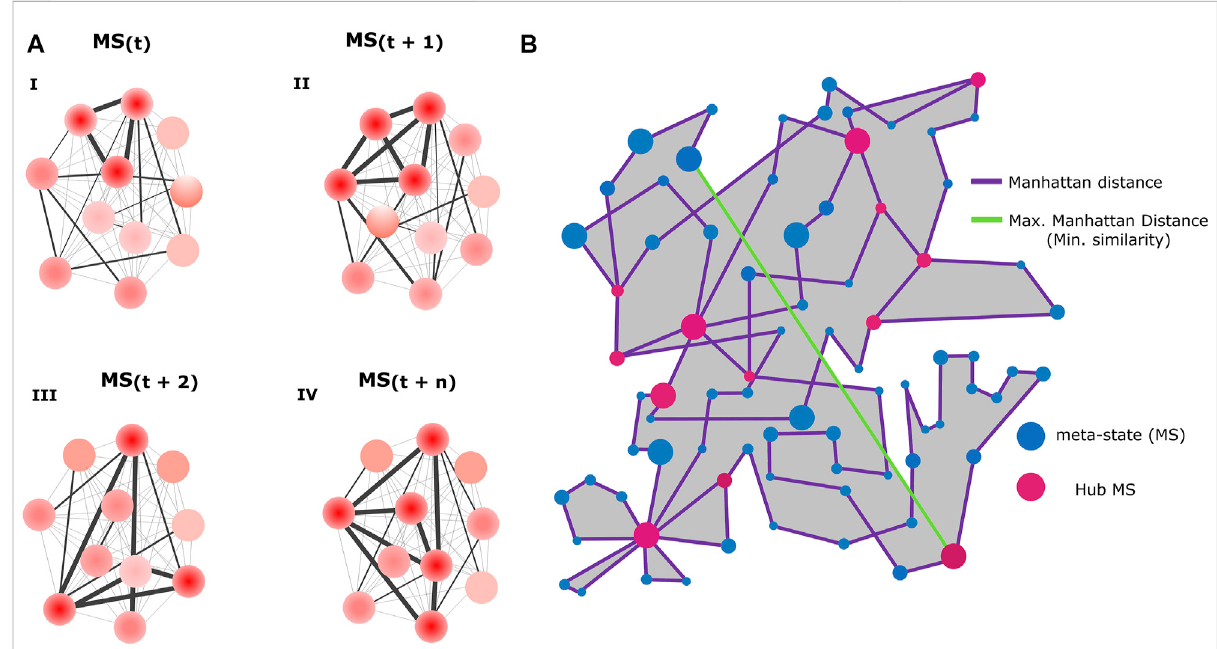
FIGURE 4 Functional connectivity-related variables. (A) Schematics represent four possible functional connectivity meta-states (MSs), corresponding to particular activity con fi gurations of the neurons conforming the network. Each circle represents a neuron and color intensity the strength of its activity (low red = low activity, high red = high activity). The thickness of the straight lines connecting the neurons re fl ects the strength of the correlationbetweenthesignalsemittedbytheneurons(thicker=highercorrelation). (B) Diagramillustratinganexampleoftheresting-stateFC fl ow of a network, with a description of all measured FC-related variables. Blue circles represent the different visited MSs. Each MS inhabits a 4- dimensional space, determined by the 4 weights associated with the independent connectivity patterns. However, for visualization purposes, in this scheme each MS is represented in a 2-dimensional space with arbitrary units. Circle size denotes the uninterrupted time (dwell time) spent by the network in each con fi guration. Purple lines represent successive transitions between different MSs. The length of the lines corresponds to the ManhattandistancebetweentwoconnectedMSs(inthespacewheretheMSsreside)andre fl ectshowdifferentaresuccessiveMSs,withlongerlines indicating higher dissimilarity. As a measure of network fl exibility, we evaluated the ability of SZ and HC networks to switch in just one step between two con fi gurations that are as differentas possible, atransitionrepresented bythe maximum distance achieved between two successive MSs(green line).ThepinkcirclesrepresentrecurringMSs(HubMSs),whichareconnectedbymorethantwolines,meaningthatthenetworkvisitedthematleast twotimes.Thegreyareacorrespondstothedynamicrange,aglobalindicatorofthepotentialdiversityofaccessibleMSs.Thelengthofthetrajectory of the purple line corresponds to the total traveled distance. Panels (A and B) were not generated from real data and constitute solely graphical